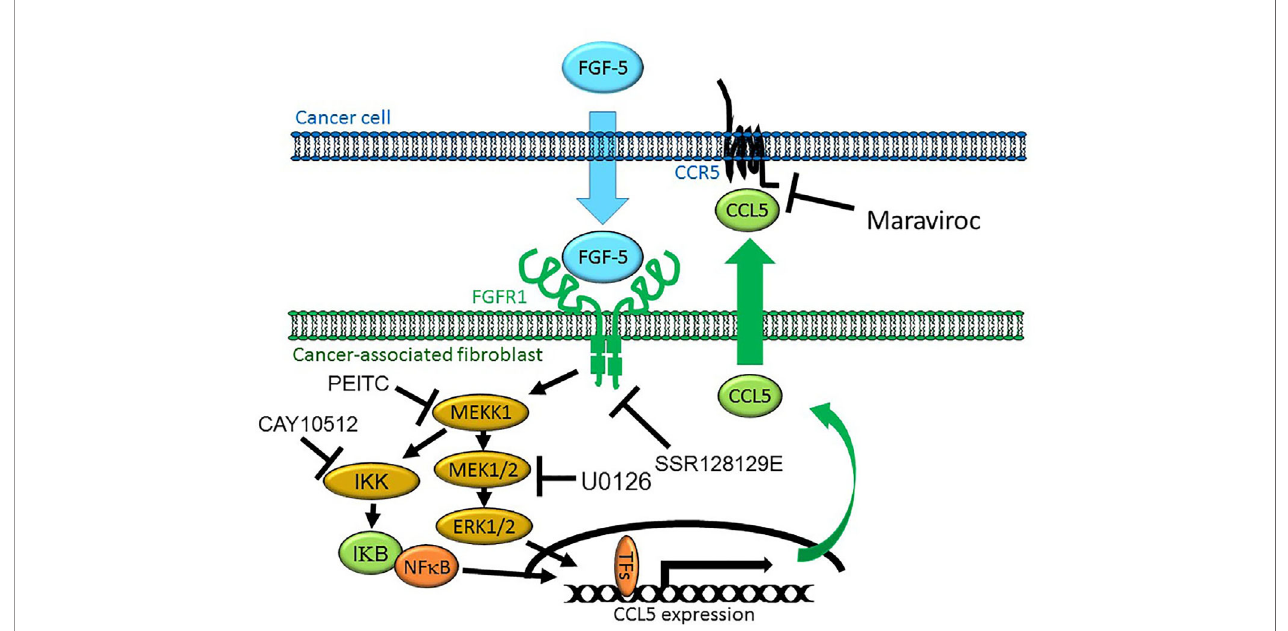
FIGURE 7 | Model of MEKK1-Ccl5 expression induced by paracrine interaction between breast cancer cells and mammary stroma. MDA-MB 231 breast cancer cells express and secrete FGF-5 in the tumor microenvironment, inducing expression of mammary fi broblast-derived CCL5 that promotes tumor cell migration. FGF-5 binds to FGFR1 proteins on the surface of mammary fi broblasts, triggering receptor tyrosine kinase activity that induces MEKK1 activation and signaling that leads to the phosphorylation of transcription factors, binding of an active transcriptional complex to the CCL5 promoter and CCL5